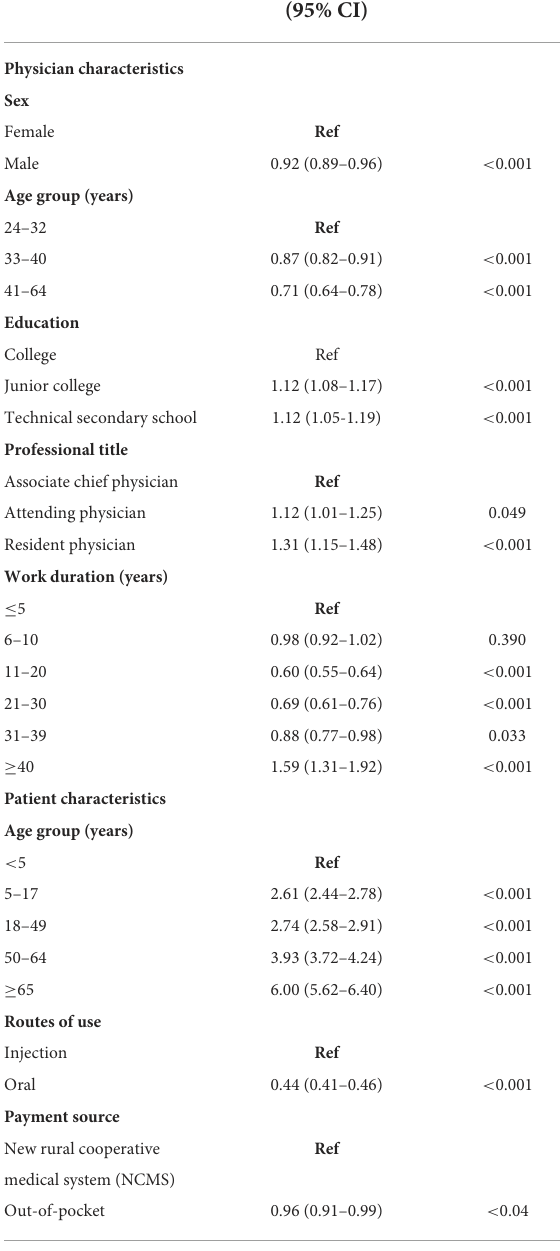
TABLE 3 Factors predicting inappropriate use of systemic glucocorticoids on multivariate